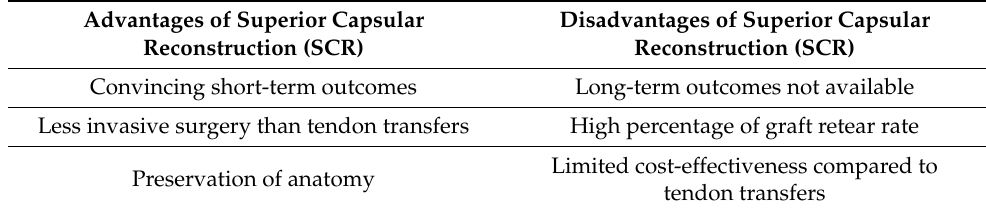
Table 5. Advantages and disadvantages of superior capsular reconstruction